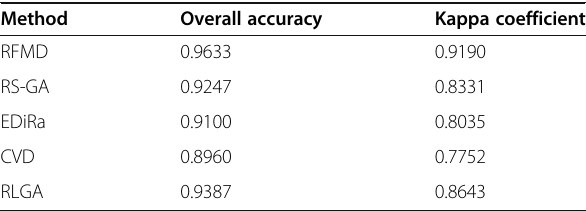
Table 15 Classification results in the second methylation dataset